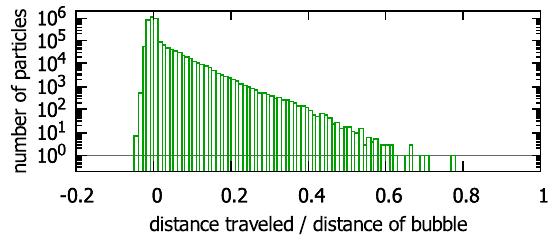
Fig. 2 The distribution of the vertical travel distance of microplastic particles relative to the travel distance of the bubble. In this simulation, particles do not stick to the bubble. The vast majority of values are around 0 (logarithmic scale), but the distribution clearly is asymmetric towards positive distances, indicating particle entrainment as a consequence of non-laminar